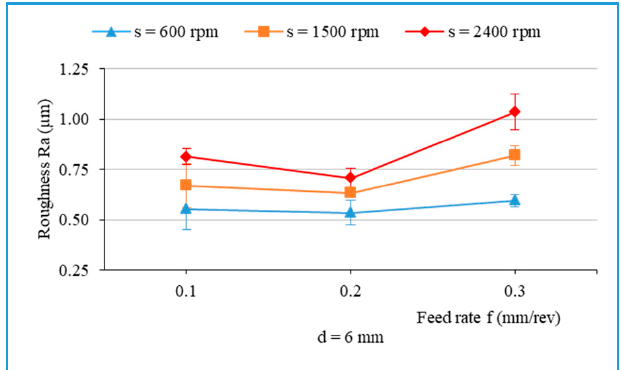
Figure 11. Surface roughness (R a ) versus the feed rate when drilling with different spindle speeds, d = 6 mm.